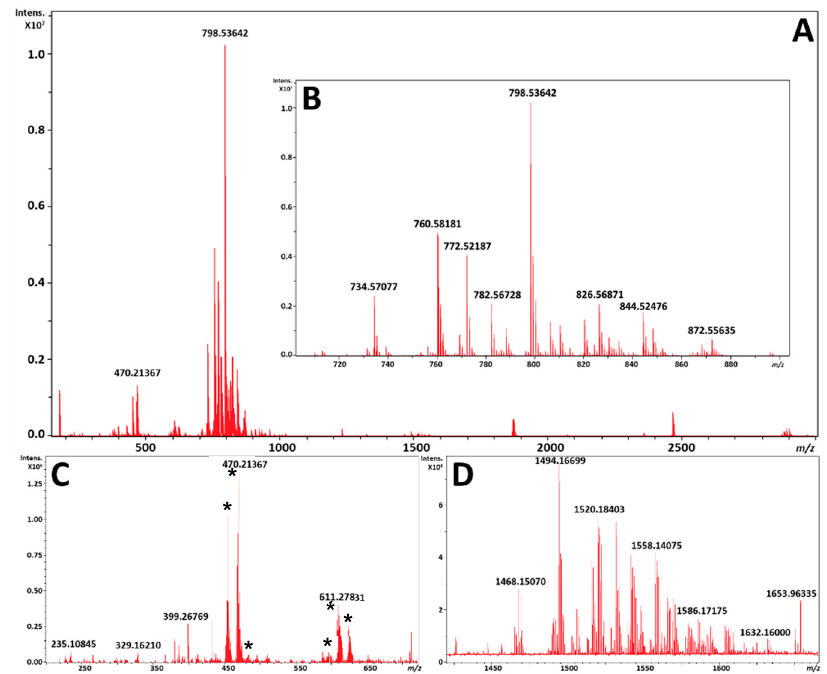
Figure 2. ( A ) is an exported average spectrum of every pixel from MALDI-MSI from FlexImaging 5.0 (Bruker Daltonics, Bremen, Germany). ( B ) is a zoomed view of the phospholipid profile from m / z 700 to 900. ( C ) is a zoomed view highlighting the matrix clusters formed from 1,5-DAN in the positive ion mode from m / z 200 to 725 marked by asterisks. ( D ) is a zoomed view of the putative cardiolipin and ganglioside profile from m / z 1425 to 1675.